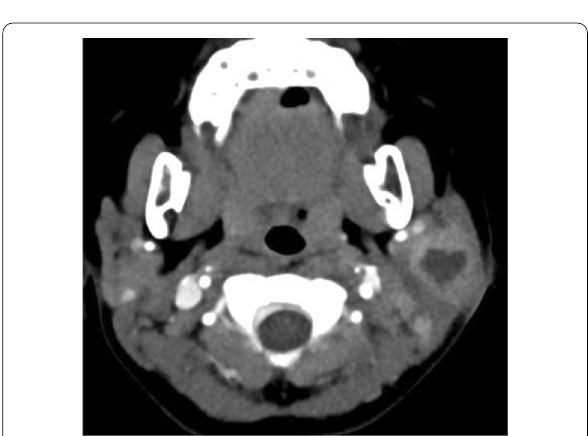
Fig. 5 Left parotid gland abscess on CT, after intravenous injection of contrast